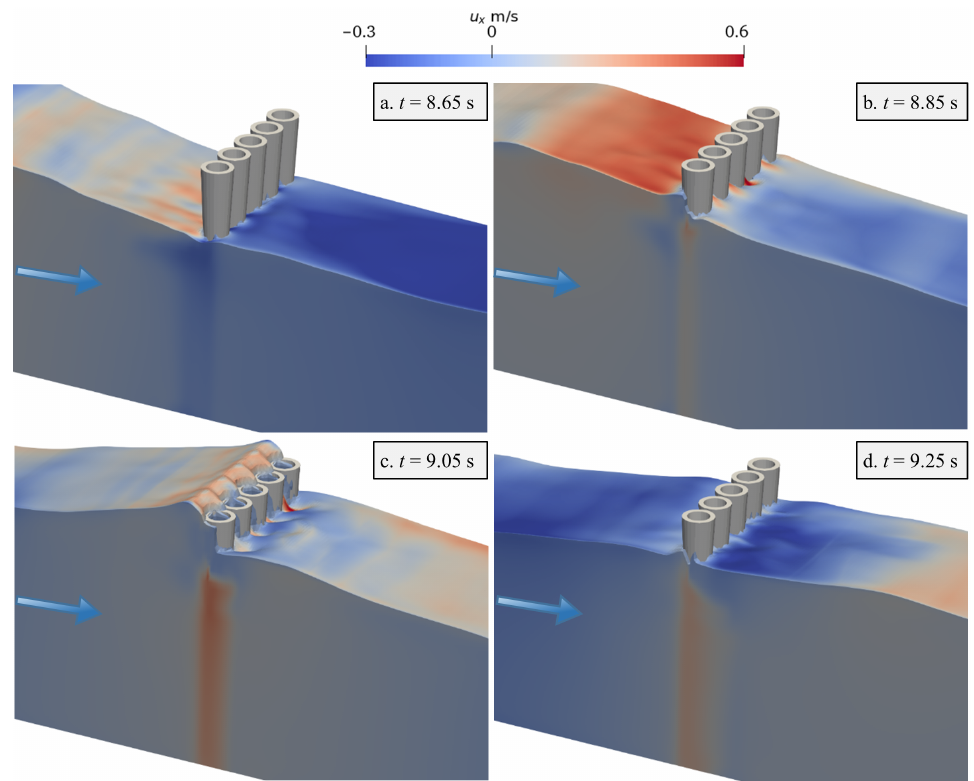
Figure 13. Wave interaction with the non-perforated CPHB ( D/H max = 0.4) at different time in- stances ( t ).